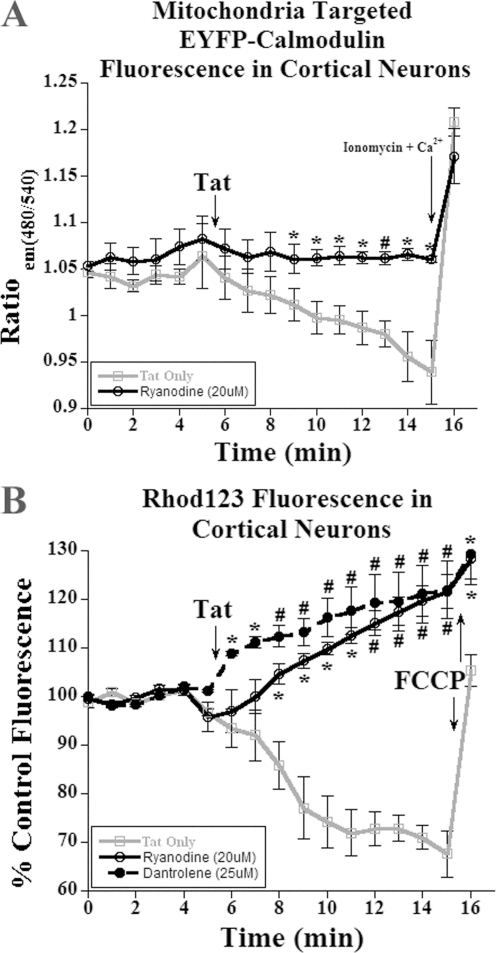
HIV-1 Tat mediated mitochondrial calcium loss and hyperpolarization is mediated through the ryanodine receptor.A, Treatment with 8 nM Tat of cortical neuron in only media resulted in a 10% loss in CFP:EYFP calmodulin fluorescence. The pretreatment with ryanodine for 30 minutes prior to exposure to 8 nM Tat inhibited the loss of fluorescent signal (n = 4; *, p<0.05; #, p<0.01). B, Treatment with 8 nM Tat of cortical neuron resulted in the rapid loss in rhod123 fluorescence, indicating mitochondrial hyperpolarization. Incubation with either an inhibitory concentration of ryanodine or the RyR inhibitor dantrolene for 30 minutes before Tat treatment [8 nM] resulted in the rapid loss in rhod123 signal, indicating mitochondrial depolarization (n = 5; *, p<0.05; #, p<0.001). Addition of the mitochondria specific protonophore, carbonyl cyanide-4(trifluoromethoxy)phenylhydrazone (FCCP; [10 µM]), initiated a rapid depolarization of the mitochondria and served as a positive control. The values of CFP:EYFP and rhod123 fluorescence were plotted and all time points were compared with the treatment group ‘Tat Only’ time points for statistical significance.